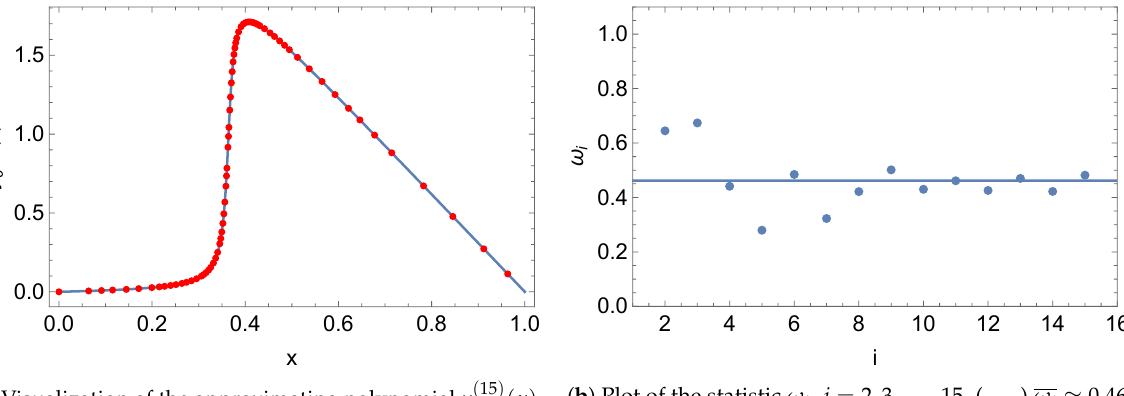
( b ) Plot of the statistic ω i , i = 2,3, . . . ,15. ( ) ω i ≈ 0.46. ( 15 ) ( x ) . A proper subset of the set of points S is shown. c